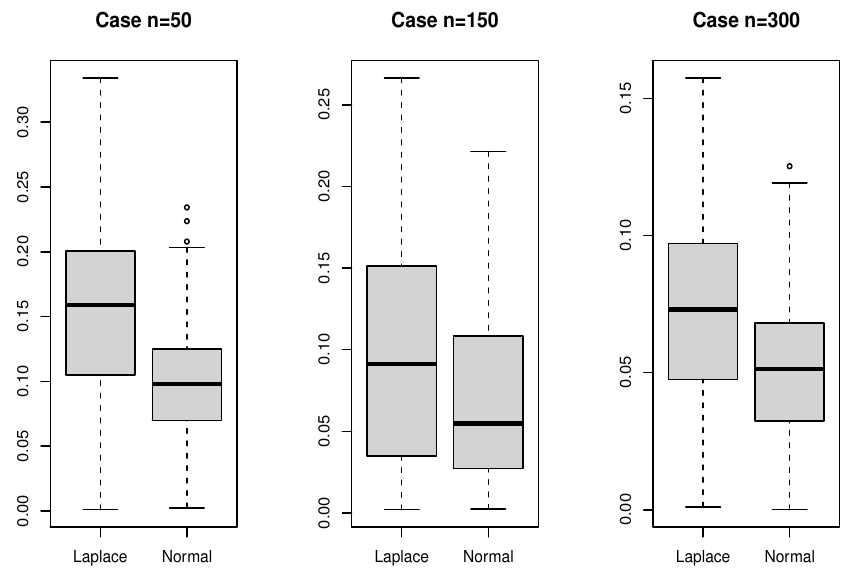
Figure 2. ASE with respect the sample